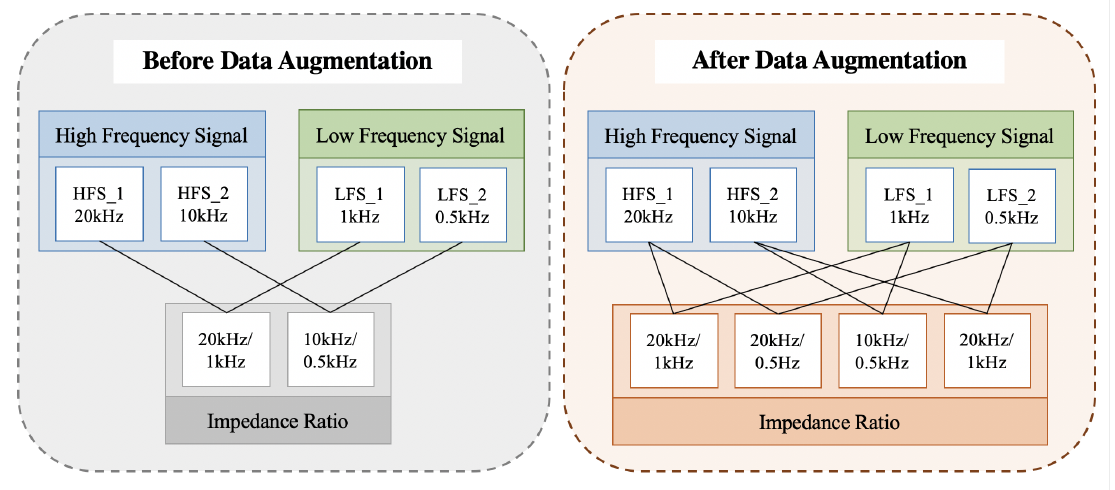
Figure 5. An example of data